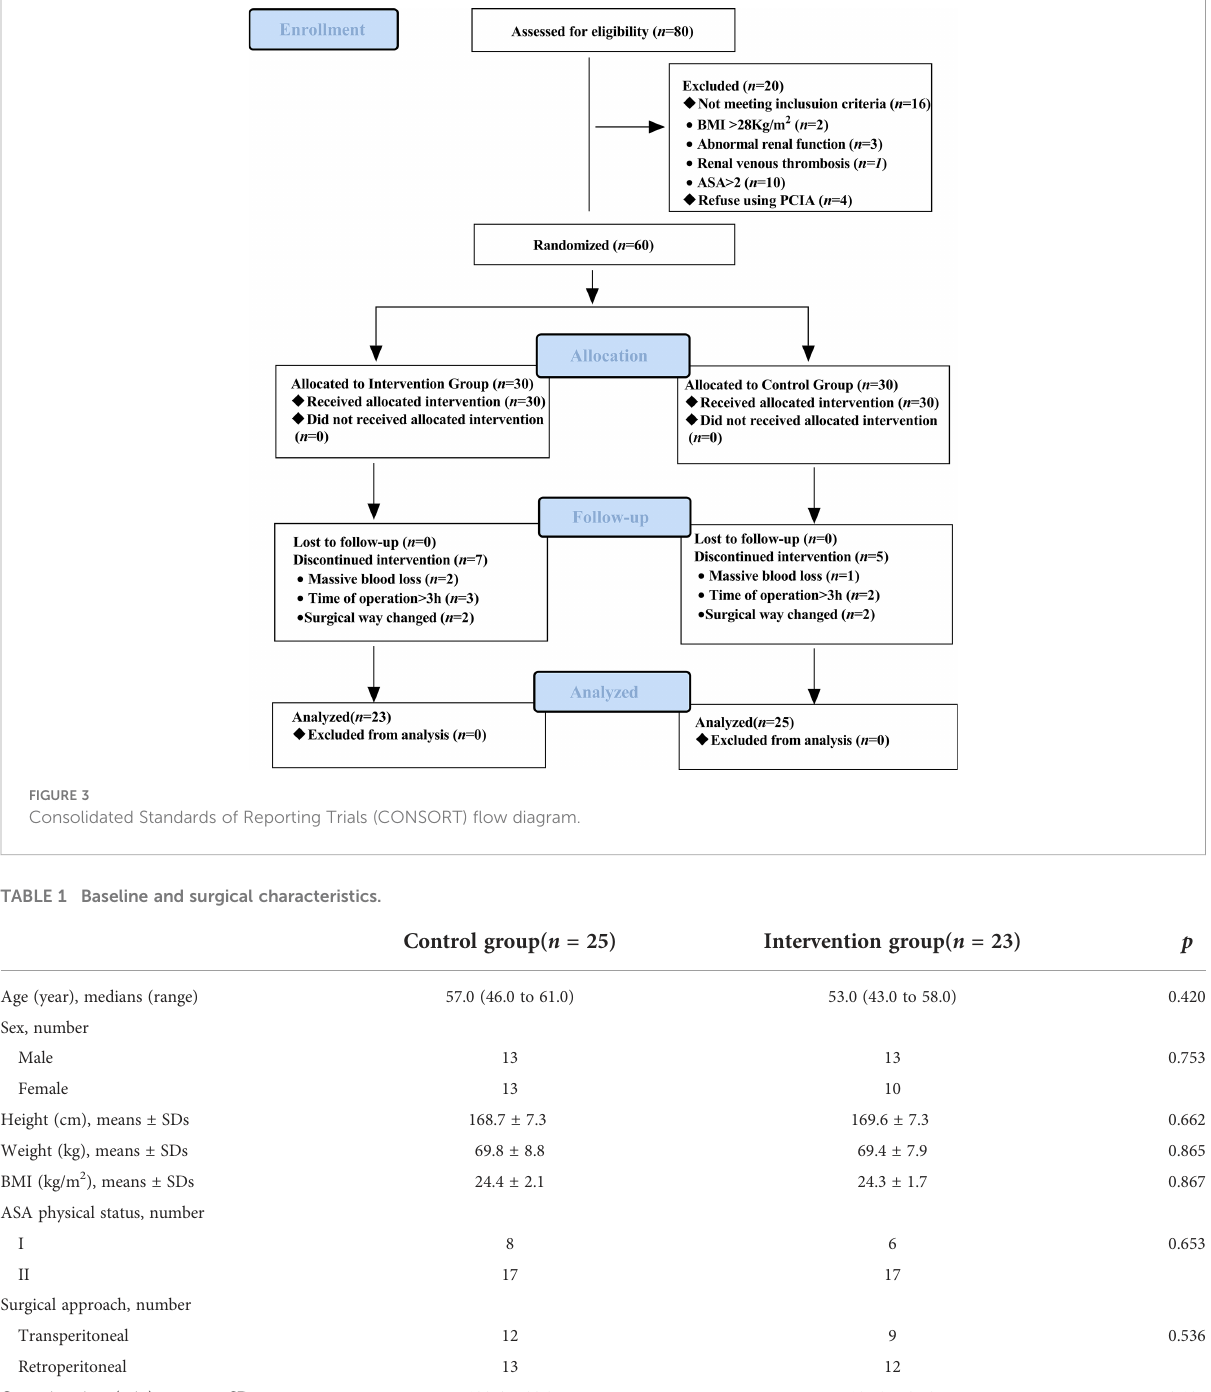
(Table 4). There was no statistically signi fi cant difference between the intervention and control groups in the